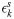
Test 2: Trend of the relative error over the parameter space.Relative error ϵks vs. μtest with n = 5 for the time instance t˜=147 ms (the violet band indicates the IQR). The maximum error is associated to μtest = 0.7875 cm, the testing-parameter instance between μtrain = 0.775 cm (the last value for which re-entry does not arise) and μtrain = 0.8 cm (the first value for which re-entry is elicited).